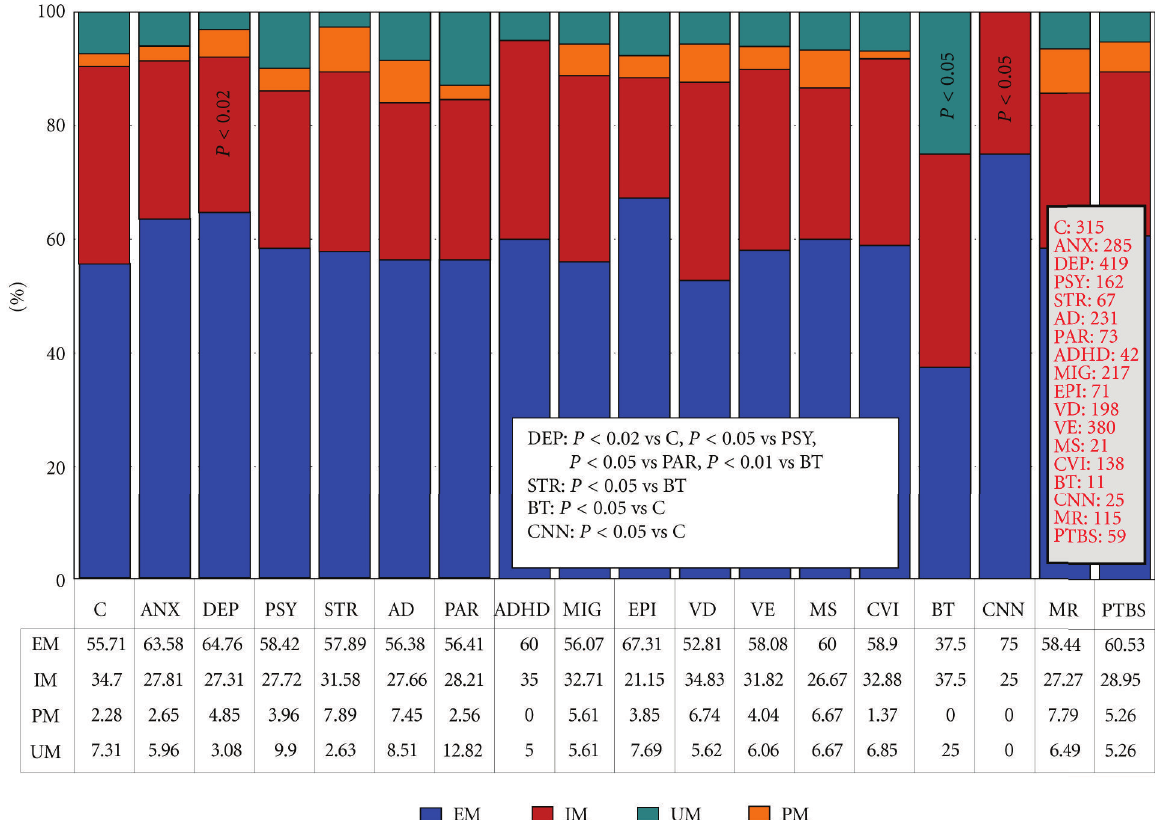
Figure 7: Distribution and frequency of CYP2D6 extensive metabolizers (EMs), intermediate metabolizers (IMs), poor metabolizers (PMs), and ultrarapid metabolizers (UMs) in patients with di ff erent CNS disorders. C: controls; ANX: anxiety; DEP: depression; PSY: